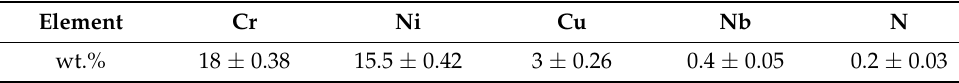
Table 1. Chemical composition of as-received CG state. Element